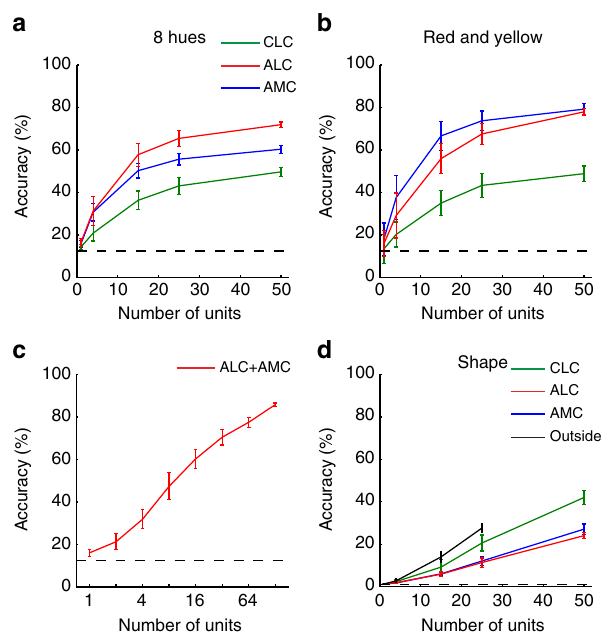
Fig. 6 Decoding shape-invariant color and color-invariant shape from color patches. a SVM models were trained to classify hues independent of shape. The population response of a set of randomly-selected units was used as the input to each model. Half of the trials were used for training and the remaining half for cross-validation. Shape-invariant hue could be signi fi cantly better decoded by AMC and ALC populations than by CLC (for 50 units, p < 0.01 for both comparisons, 2000 iterations of bootstrapping). Furthermore, ALC showed better overall decoding than AMC ( p = 0.013). Dashed line indicates chance level (1/8 = 12.5%). Results are averages across 2000 iterations of random sampling. Errorbars represent s.d. b similar to ( a ), but only quanti fi es decoding accuracy for two hue categories: red and yellow. Decoding based on AMC is better than ALC, but not signi fi cant ( p = 0.185). c similar to ( a ), but for a combined population of anterior color-patch neurons. d similar to ( a ), but for hue-invariant shape decoding. CLC is signi fi cantly better than ALC and AMC (for 50 units, p < 0.01 between CLC and ALC, p = 0.028 between CLC and AMC). Furthermore, neurons outside color patches showed better performance than color-patch neurons, but only signi fi cantly better than ALC and AMC (For 25 units, p < 0.01 between outside and ALC, p = 0.019 between outside and AMC and p = 0.186 between outside and CLC). Dashed line indicates chance level (1/82 =